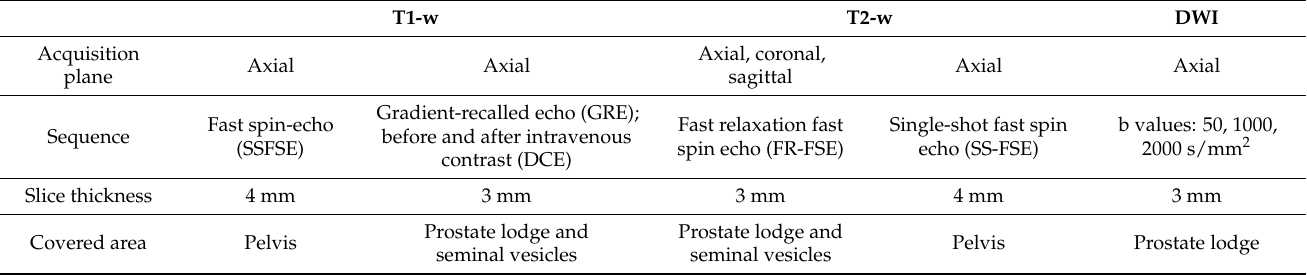
Table 2. MRI acquisition